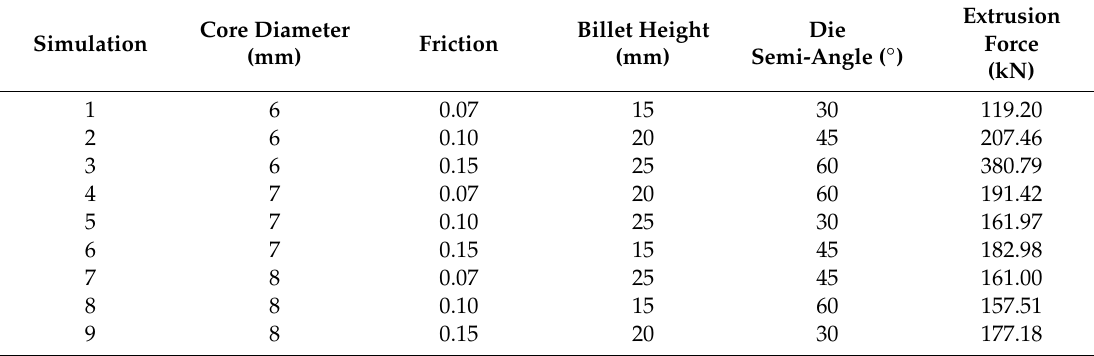
Table 12. Taguchi’s orthogonal array for extrusion force.